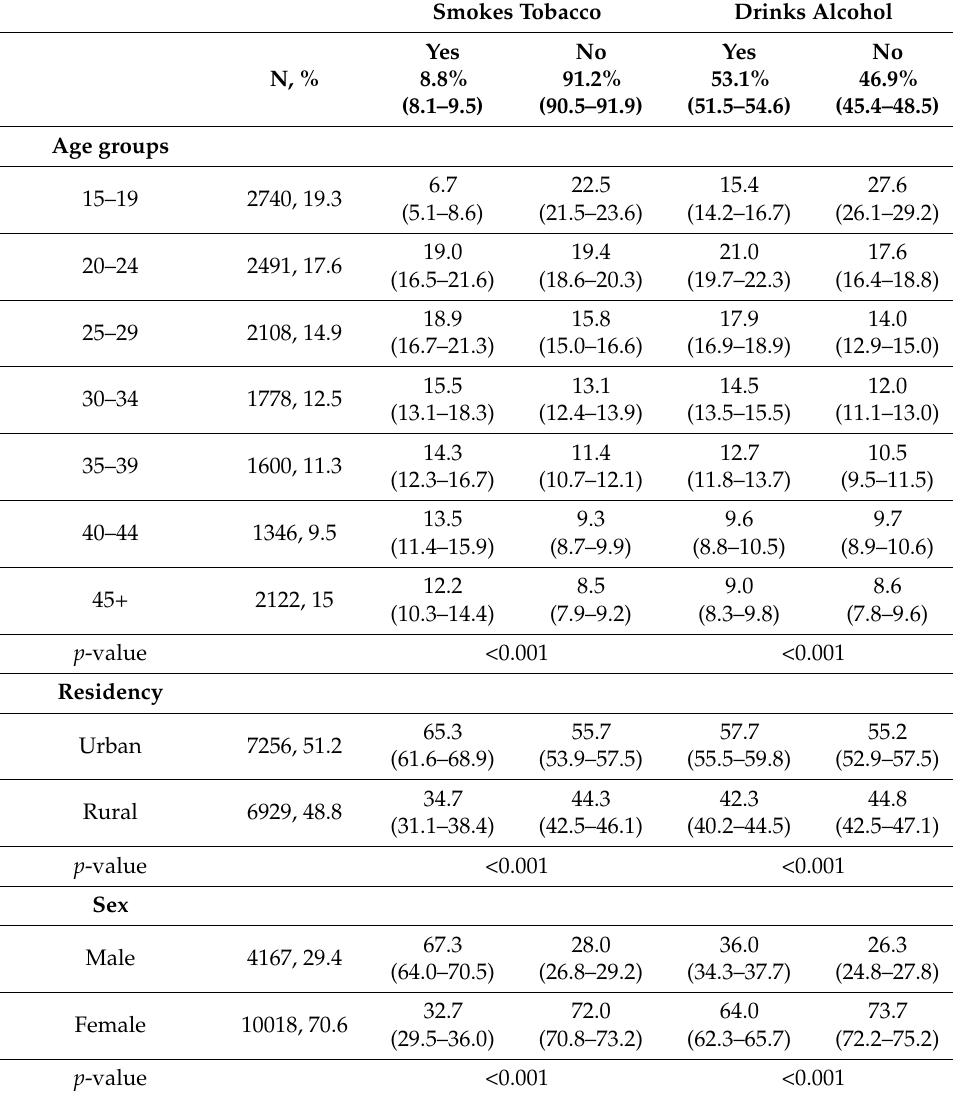
Table 1. Basic profile of the participants. ( n =